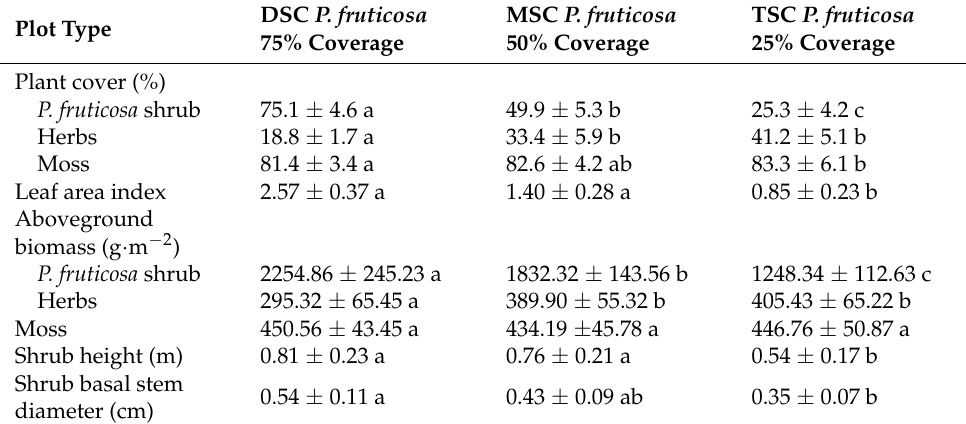
Table 1. Plant community structure and biomass in the DSC, MSC, and TSC P. fruticosa shrub plots during the growing season of